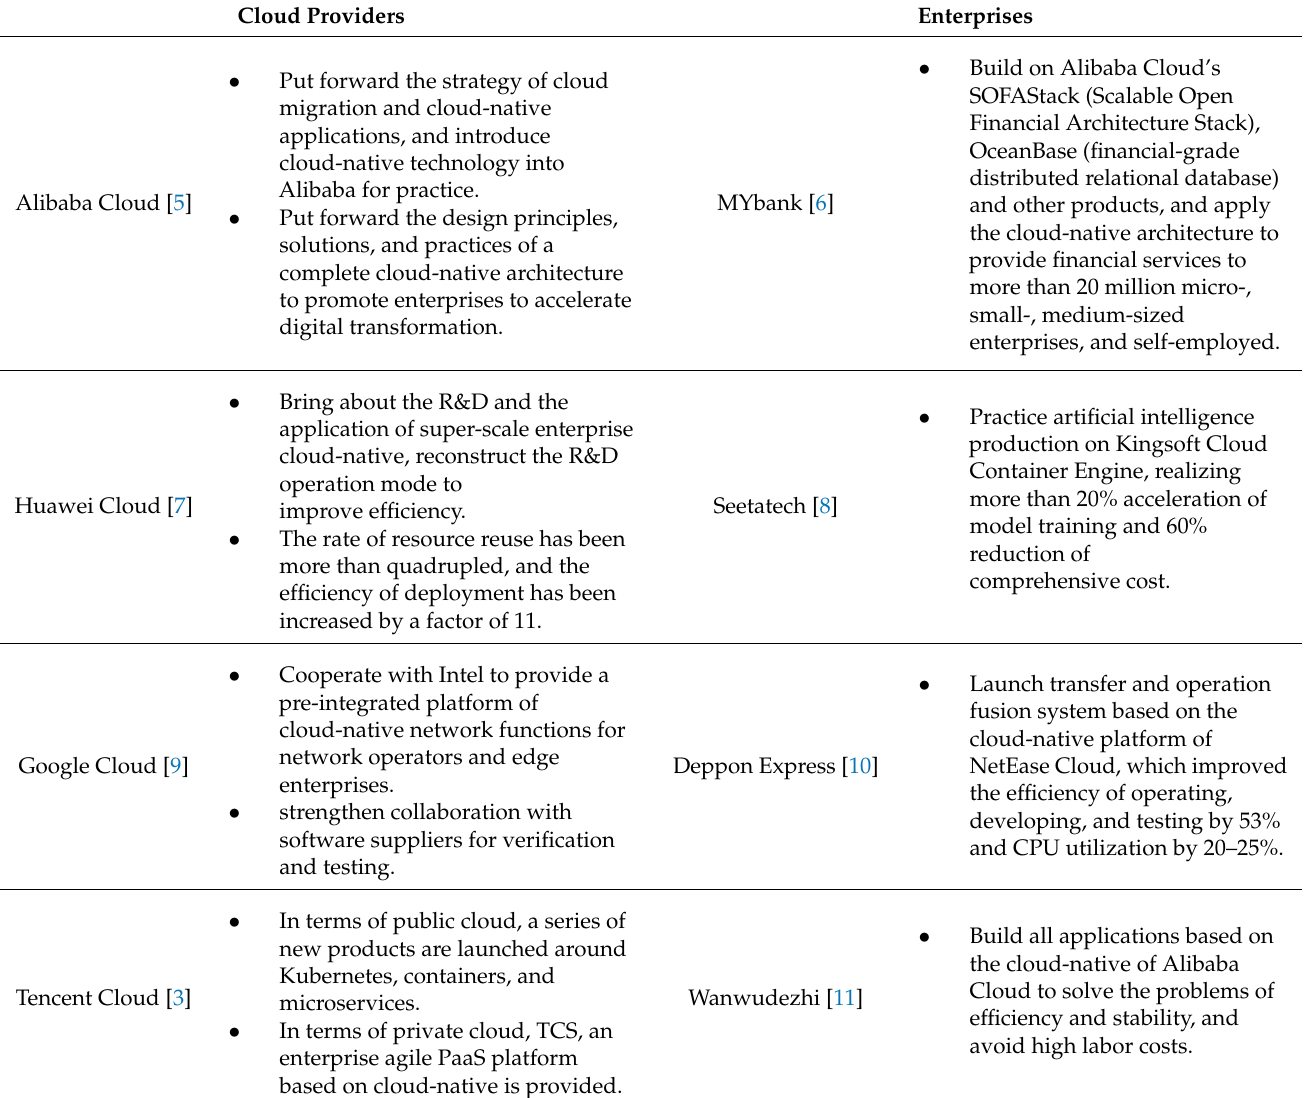
Table 1. Productive practice of cloud-native in cloud providers and